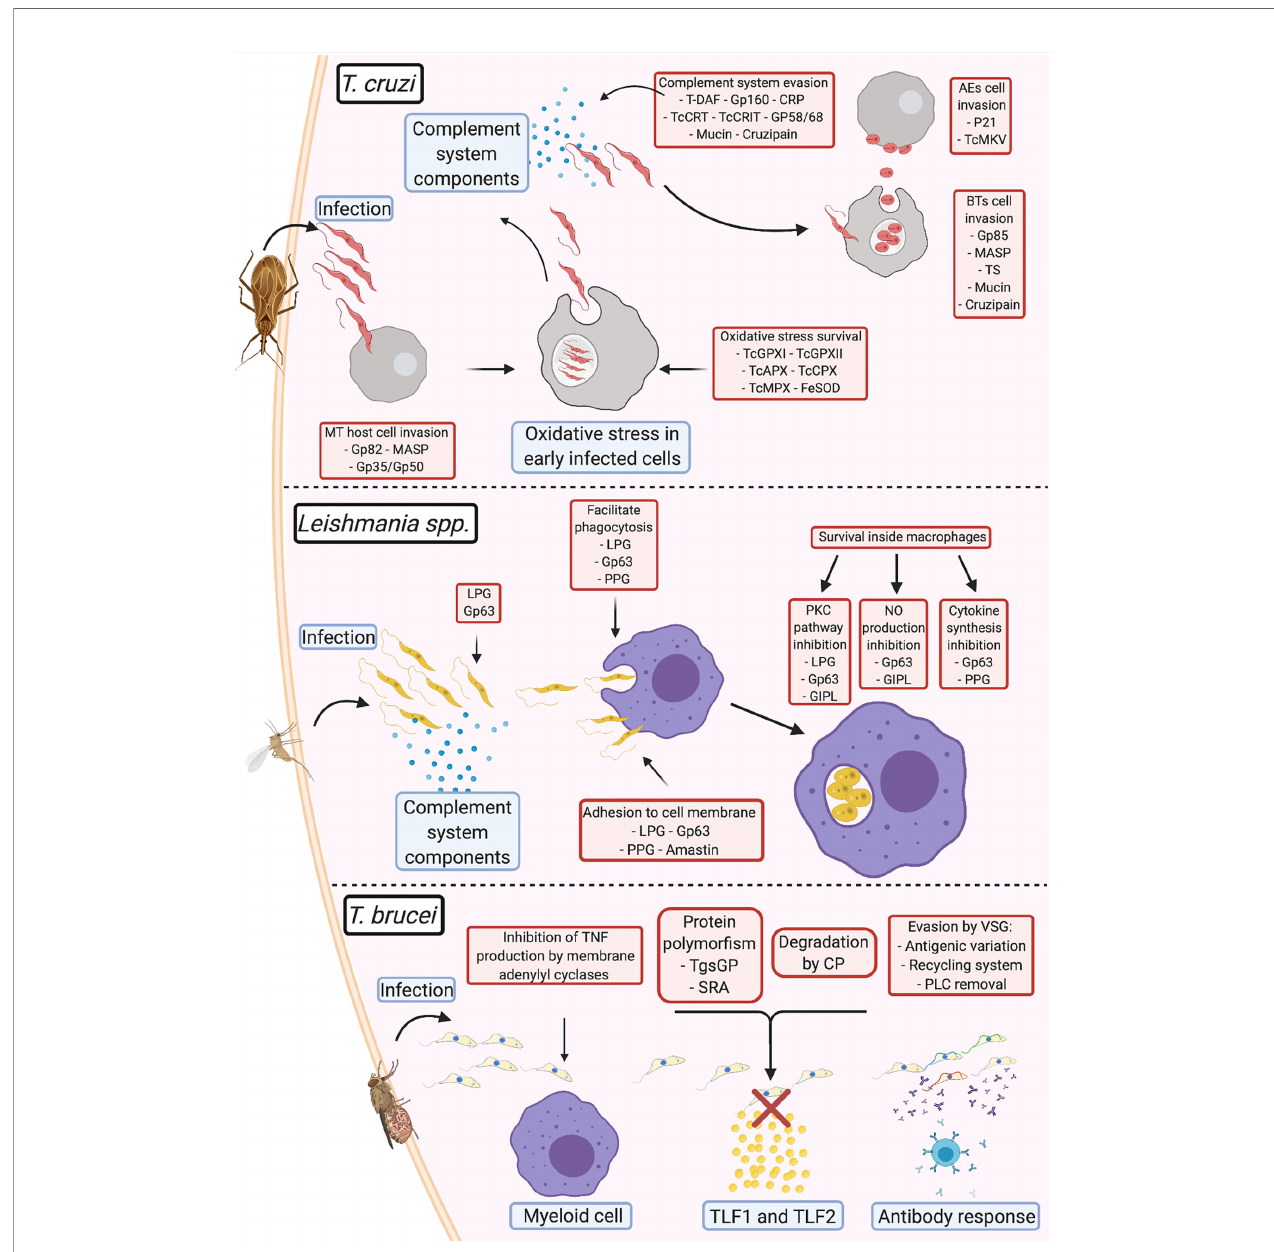
FIGURE 1 | Comparison of virulence strategies adopted by human pathogenic trypanosomatids Trypanosoma cruzi : During infection, the metacyclic trypomastigotes invade cells at the site of entrance aided by gp82, MASP, and gp35/gp50; once inside the cell, TcGPXI TcGPXII, TcAPX, TcCPX, TcMPX, and FeSOD protect the parasite from the oxidative stress response; after multiplication and return to the extracellular milieu, T. cruzi evades the complement system (using T-DAF, gp160, CRP, TcCRT, TcCRIT, gp58/68, mucin, and cruzipain) until they invade new cells via membrane adhesion (using gp85, MASP, TS, mucin, and cruzipain). After a fresh round of multiplication and egression from the infected cell, if the parasite exits as an extracellular amastigote, it can directly infect new cells using surface protein adhesion (P21 and TcMKV). Leishmania spp. : Complement system evasion in Leishmania is primarily mediated by gp63 and lipophosphoglycans (LPGs). This interaction opsonizes the parasites and facilitates adhesion to the membrane of phagocytic cells, with assistance from proteophosphoglycans (PPGs) and amastins. Upon entry into the parasitophorous vacuole, gp63, LPGs, glycosylinositol phospholipids, and PPGs block the pathways that produce components that damage Leishmania and promote parasite survival and multiplication. T. brucei : To prevent immediate elimination, the parasite suppresses TNF- a production from the membrane adenylyl cyclases in myeloid cells. Evasion from TLF1 and TLF2 by T. b. gambiense is mediated via cysteine proteases and polymorphisms in the TgsGP receptor; T. b. rhodesiense prevents interaction with the same lytic factors using the serum resistance- associated proteins present on the membrane. In T. brucei , variant surface glycoproteins (VSGs) are primarily responsible for antibody response evasion. This involves: (1) prevention of the binding of antibodies to the cell membrane via antigenic variation, (2) elimination of antibodies bound to VSG by endocytosis of the VSG-antibody complex in the VSG recycling system, or (3) cleavage of the antigen-antibody complex by phospholipase C